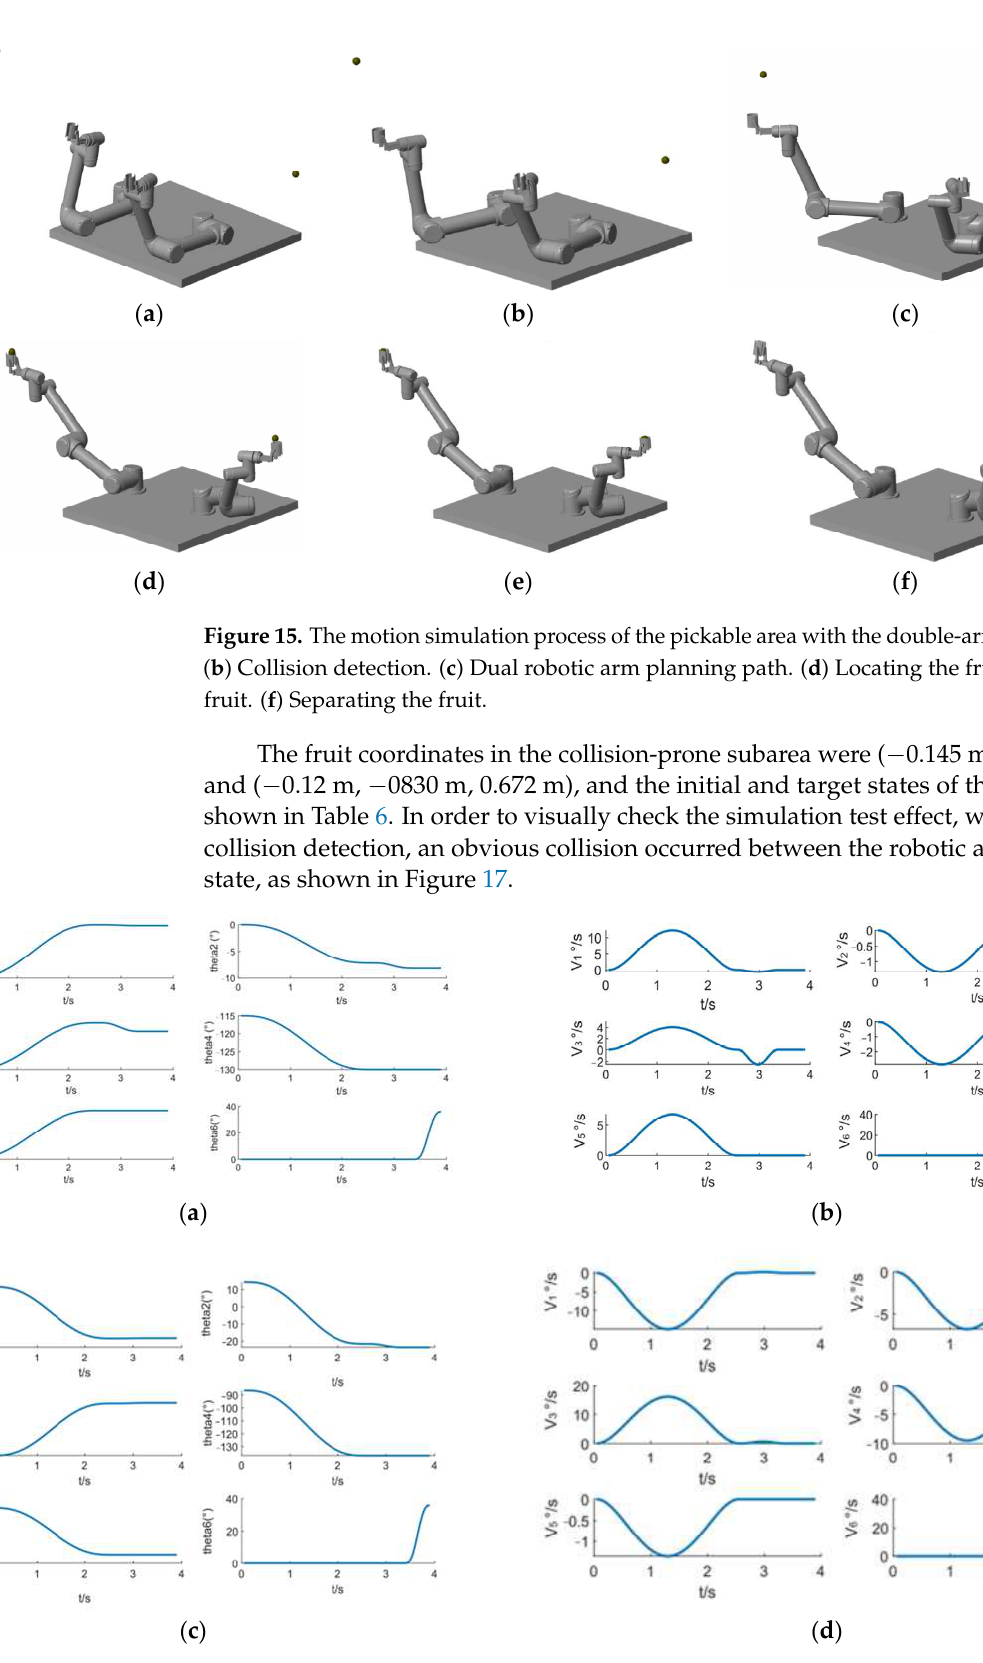
Figure 16. Motion simulation results of the pickable area with double-arm. ( a ) Left arm joint angle change curve. ( b ) Left arm joint angular velocity variation curve. ( c ) Right arm joint angle variation curve. ( d ) Right arm joint angular velocity variation curve.